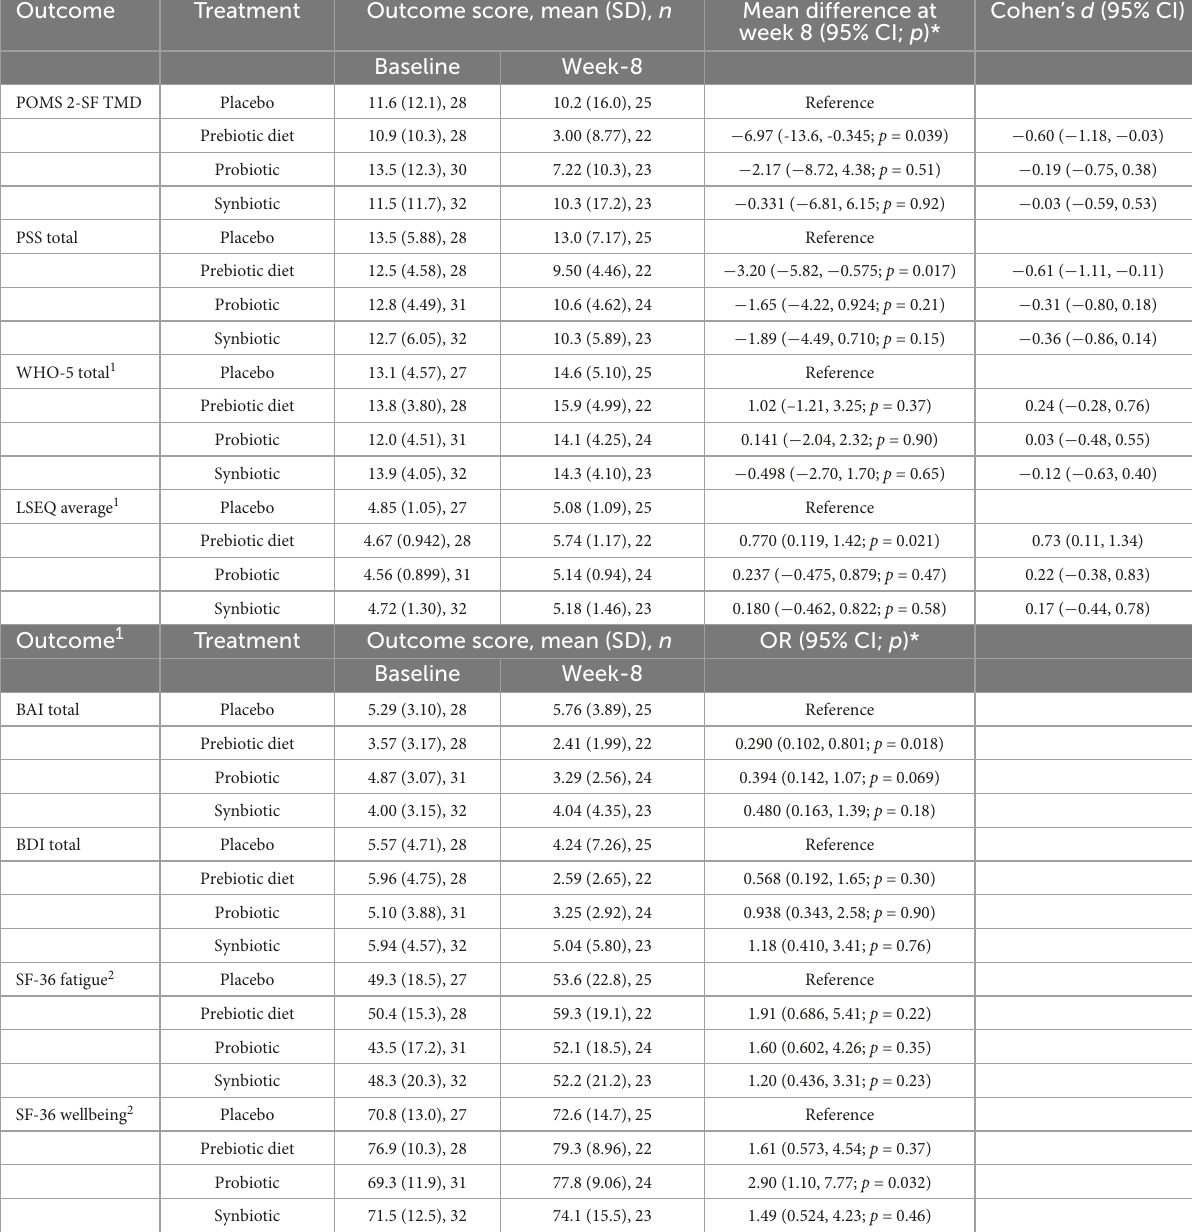
TABLE 2 Effect of treatments on primary and secondary